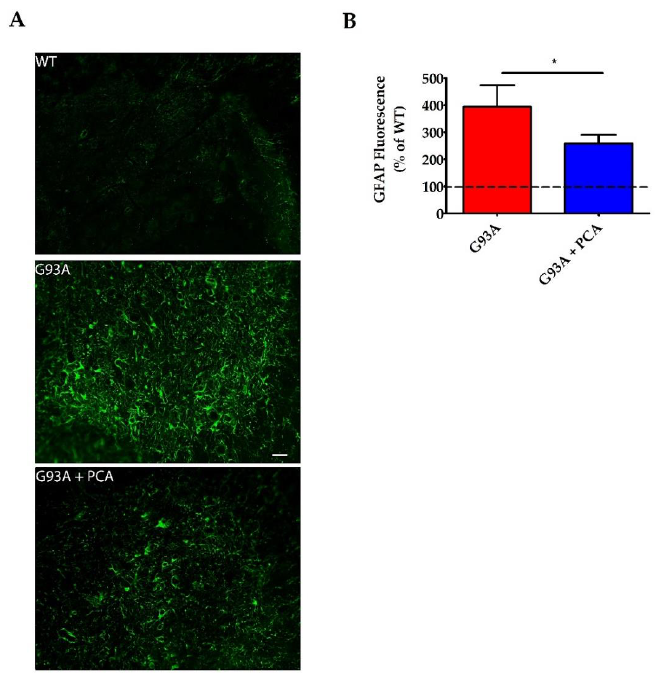
Figure 6. PCA treatment significantly reduces astrogliosis in the ventral horn of the spinal cord in the hSOD1 G93A mouse model of ALS. ( A ) Representative images of lumbar spinal cord ventral horns stained for GFAP from wildtype control mice (WT), untreated hSOD1 G93A mice (G93A), and